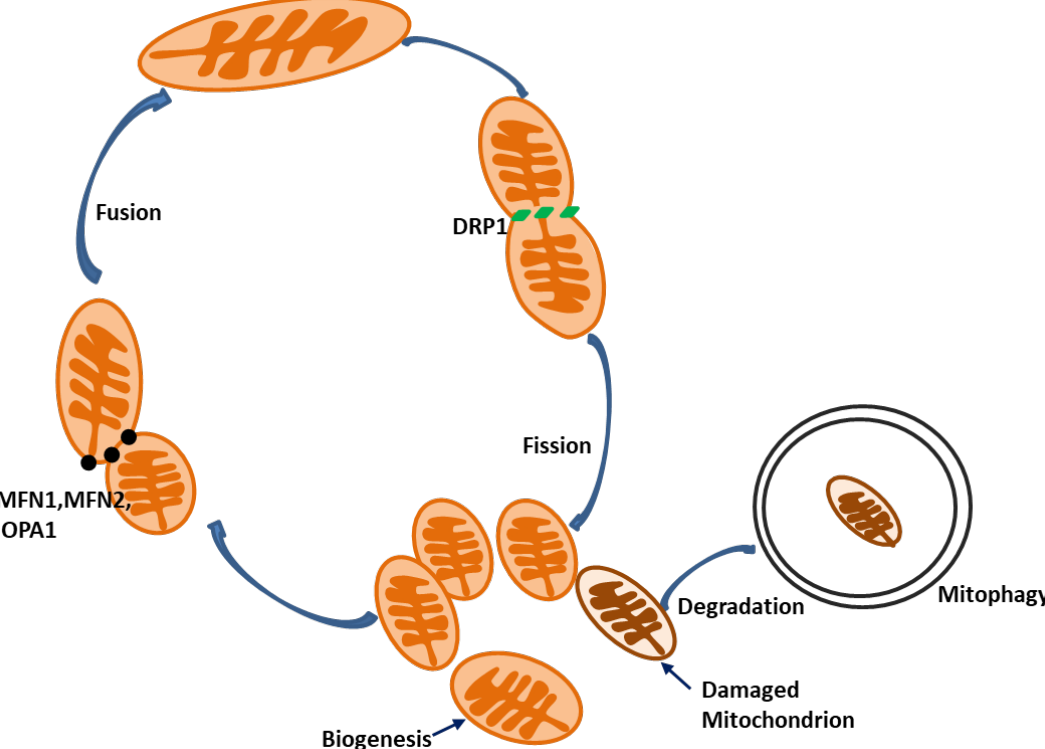
Figure 1. Mitochondrial quality control. Mitochondrial dynamics, mitophagy and biogenesis are